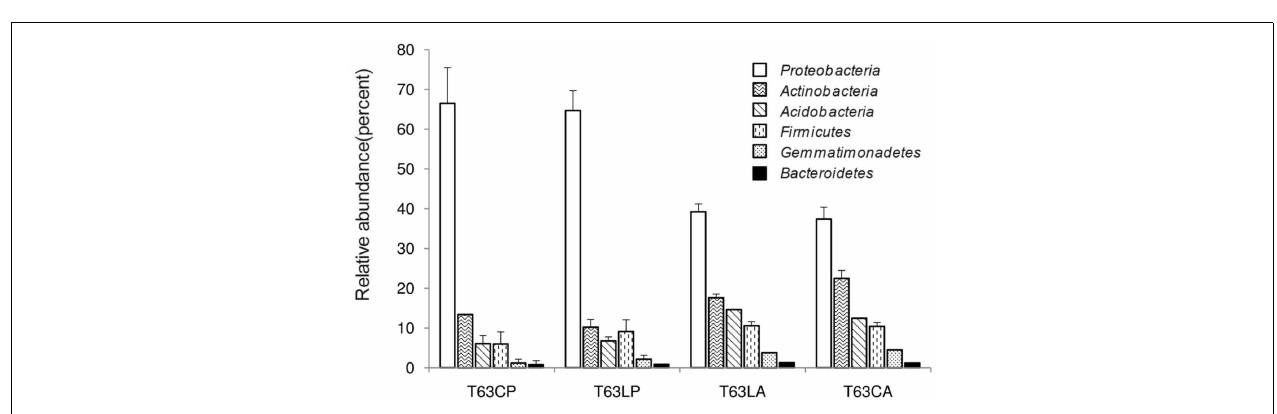
FIGUREA5 | Relative abundance of dominant phyla detected for soils spiked with phenanthrene (LP: phenanthrene-spiked Luvisol, CP: phenanthrene-spiked Cambisol) or not (LA: Luvisol control, CA: Cambisol control) on day 63 (T63).